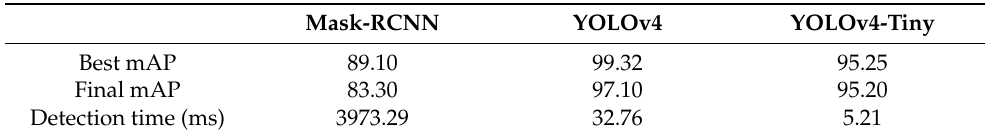
Figure 7. Trash detection using the custom Mask-RCNN model and trash detection using the custom YOLOv4 model. The YOLOv4 and YOLOv4-tiny had a much faster inference time in comparison with Mask-RCNN. Table 3 provides a clear outline of the best mAP and the respective inference time that was achieved for each of those models. These detection speeds were obtained when testing using a GPU NVIDIA GeForce GTX1650 on the computer. Table 3. mAP and detection time